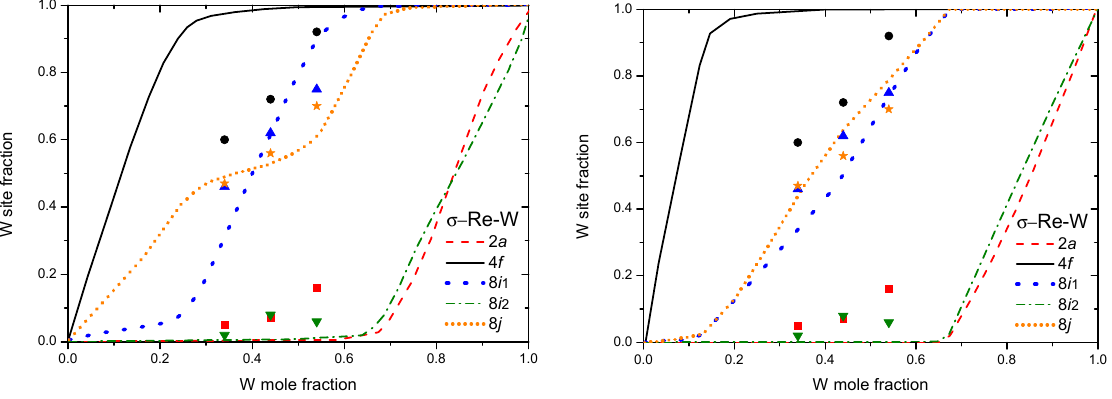
Figure 4. W site fraction in σ Re-W, obtained by CWM-CVM at 500 K ( left ) [29], and obtained by BWA at 300 K ( right ) [32]. Experimental points from [29].